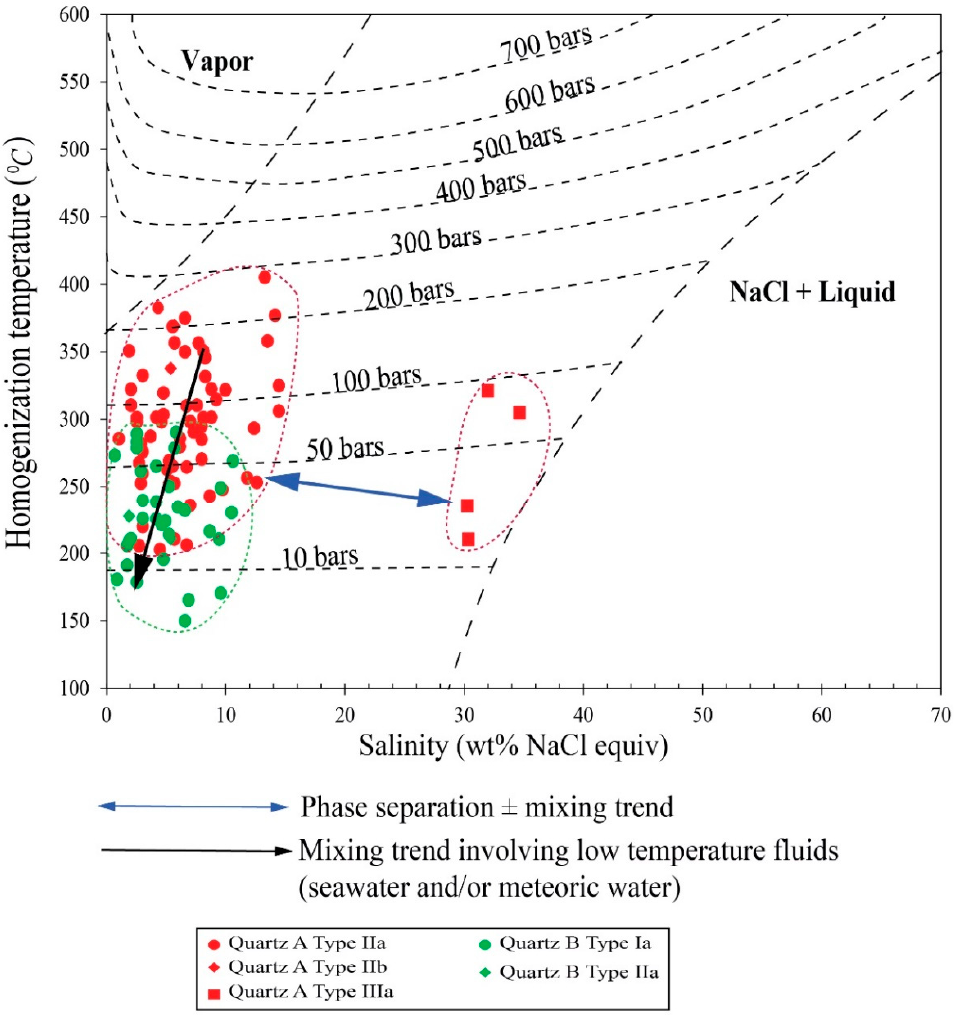
Figure 13. Pressure estimation from fluid inclusion data for the Nabeba iron deposit. Isobars were calculated from the equations of Driesner and Heinrich [29].